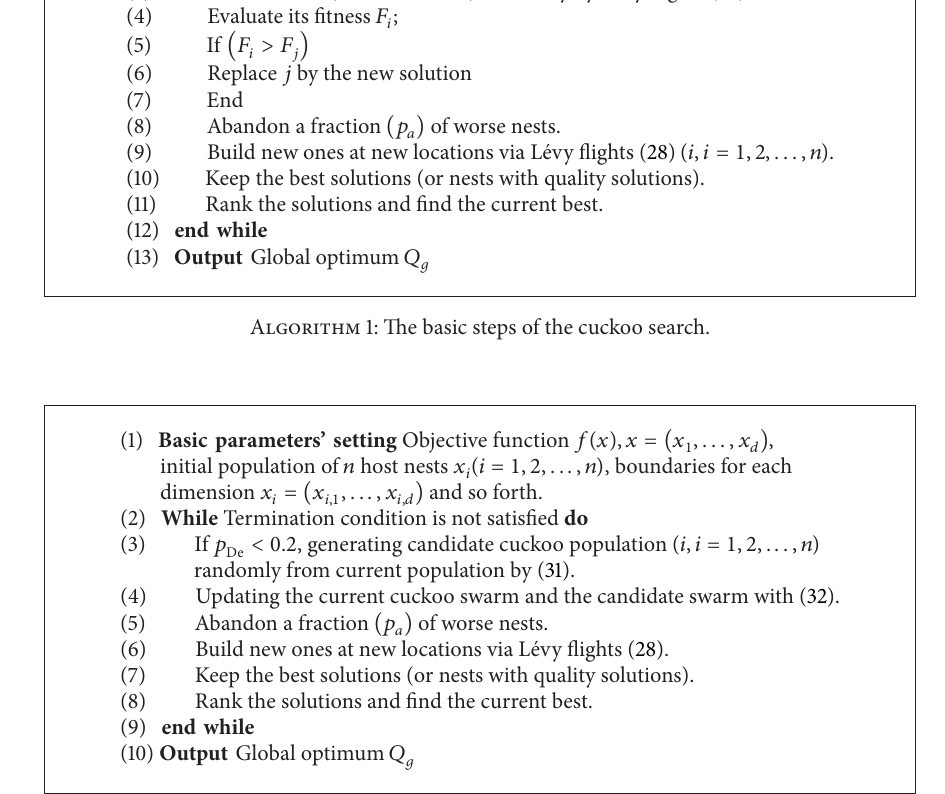
Algorithm 2: Cuckoo search oriented statistically by differential evolution